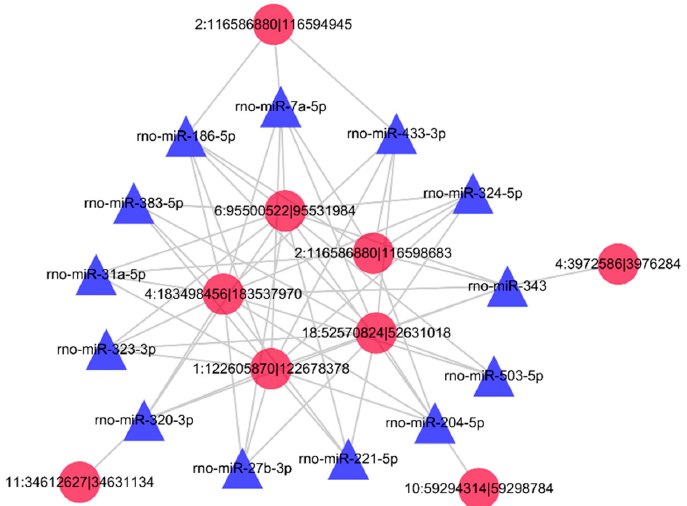
Figure 5. Interactions between circRNAs and miRNAs. The network was created with the miRanda program. The relationships between differentially expressed circRNAs and miRNAs that may target FSHb and LHb were predicted and are represented in the network. The red circles in the figure represent the differentially expressed circRNAs, and the blue boxes represent the miRNAs that may target Fsh β and Lh β .